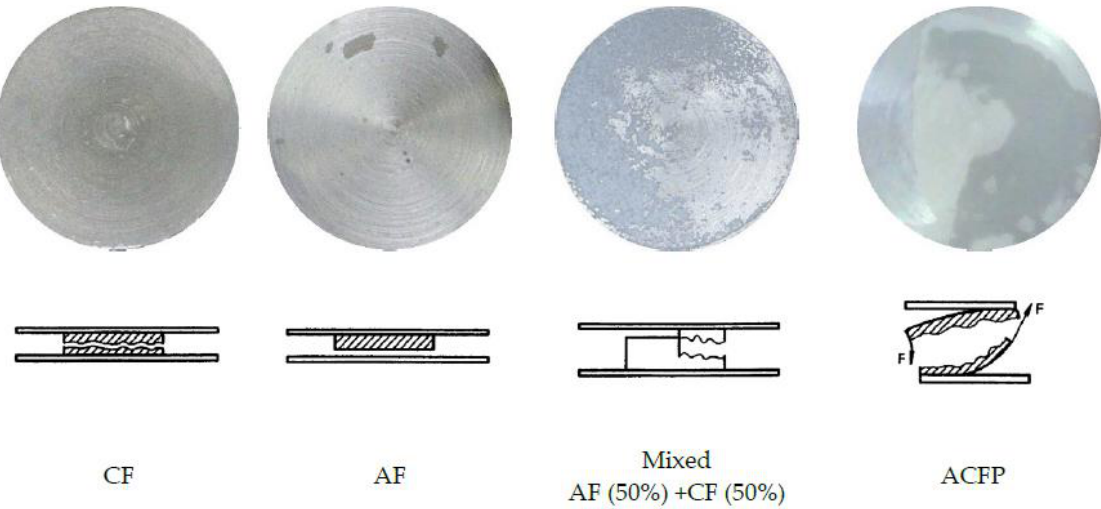
Figure 6. Main failure patterns of the tested adhesive joints [20].